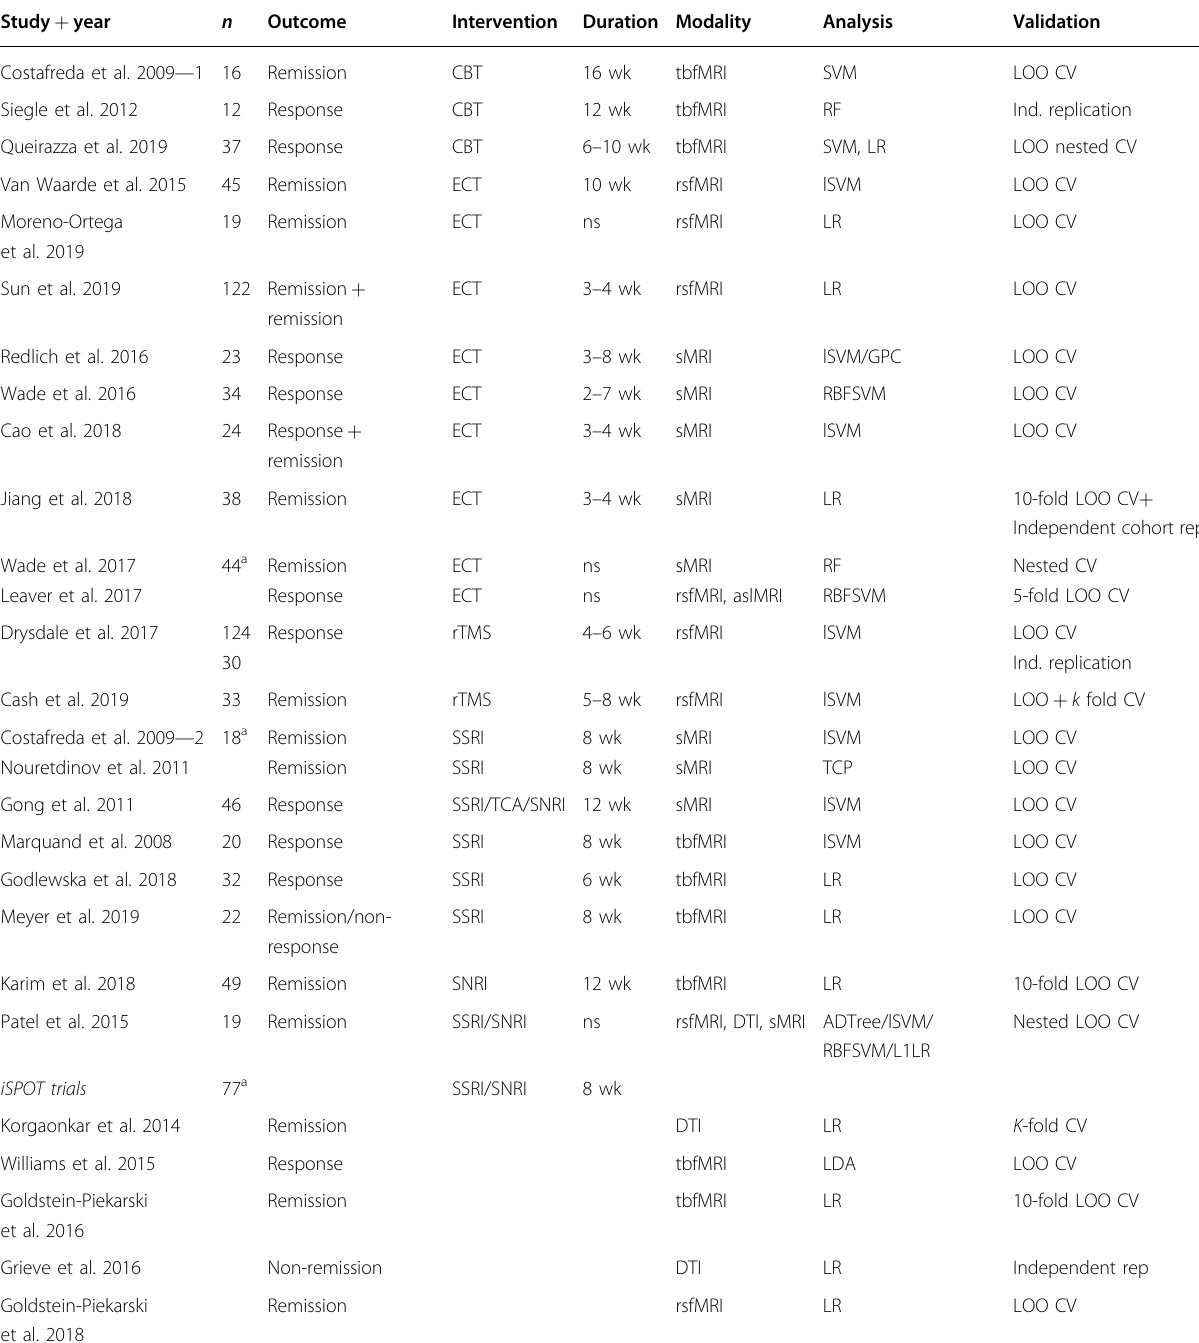
Table 1 Methodological summary of the